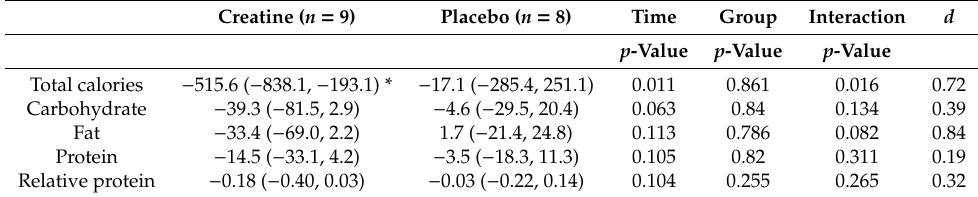
Table 2. Mean absolute changes (95% confidence intervals) from baseline to six weeks for total calories (kcal / day), macronutrients(carbohydrate, fat, protein; grams / day)andrelativeprotein(g / kg body mass). Creatine ( n = 9) Placebo ( n = 8)